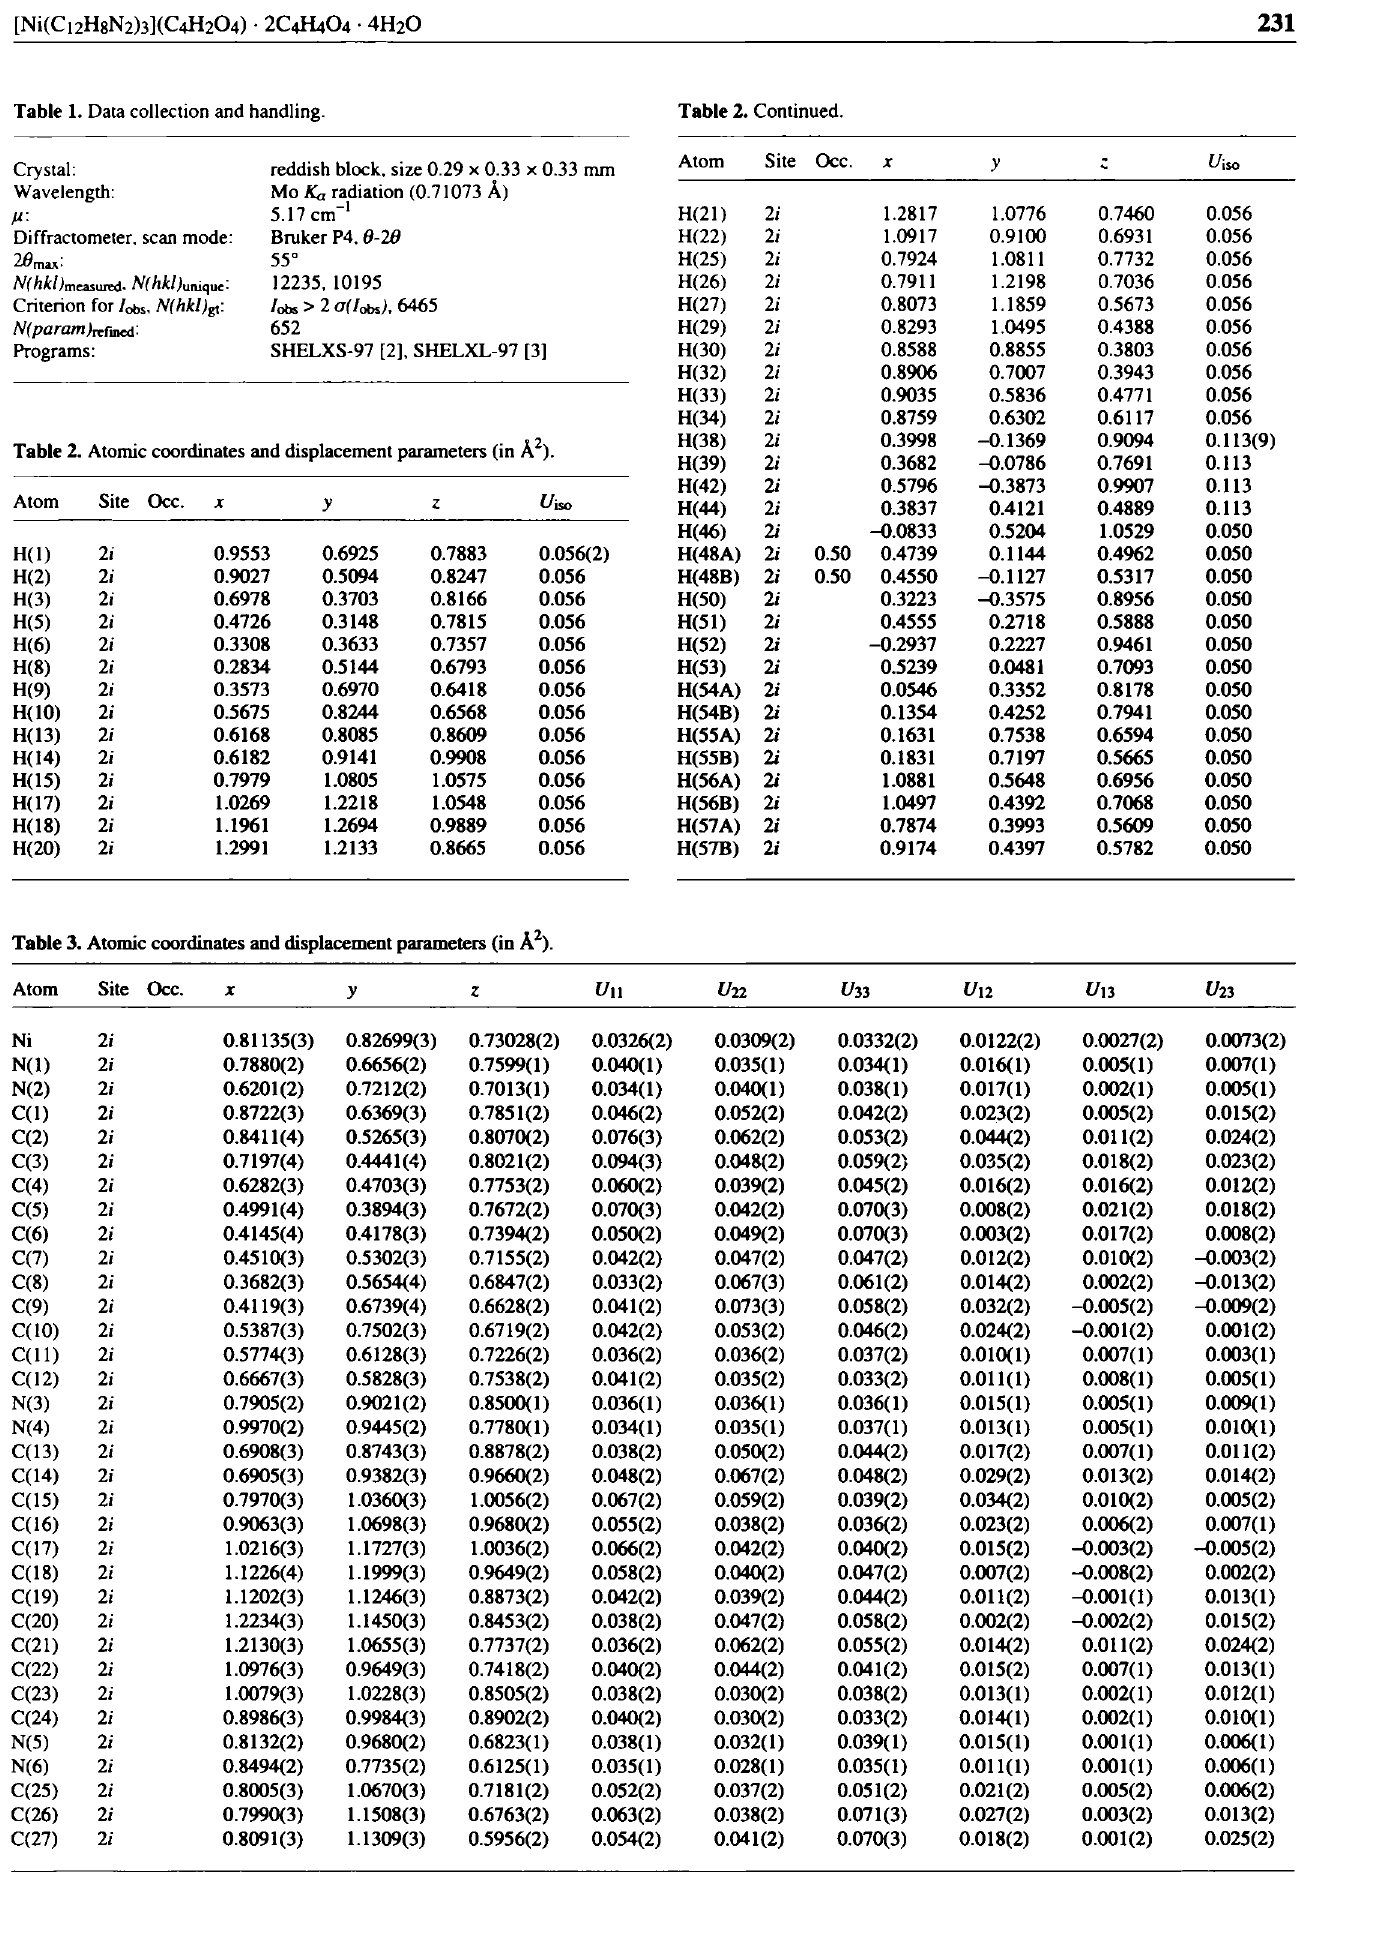
Table 1. Data collection and handling. Table 2. Continued.